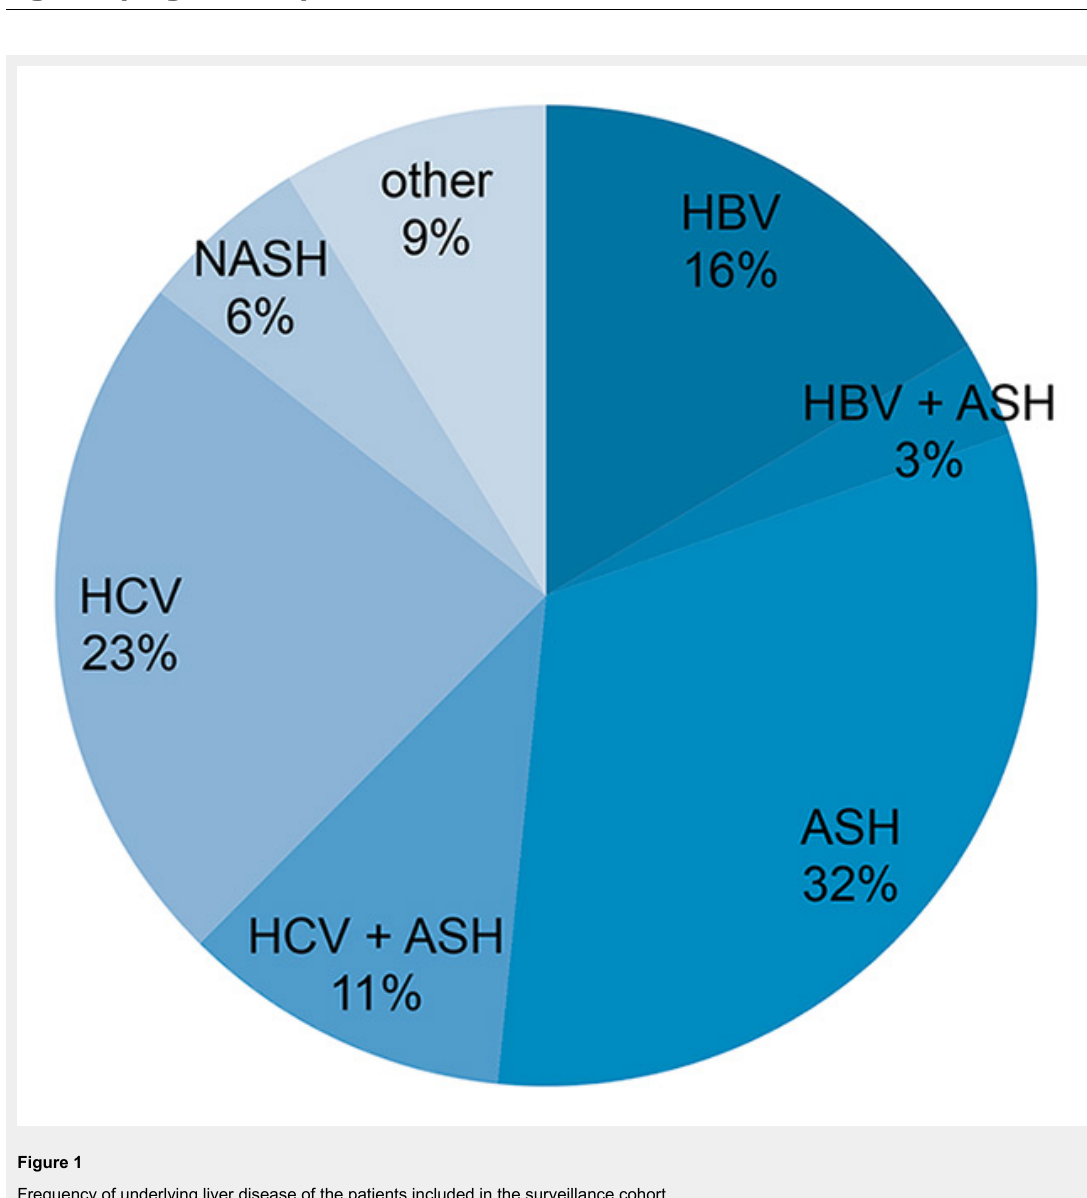
Figure 1 Frequency of underlying liver disease of the patients included in the surveillance cohort. ASH = alcoholic steatohepatitis; HBV = chronic hepatitis B; HCV = chronic hepatitis C; NASH = nonalcoholic